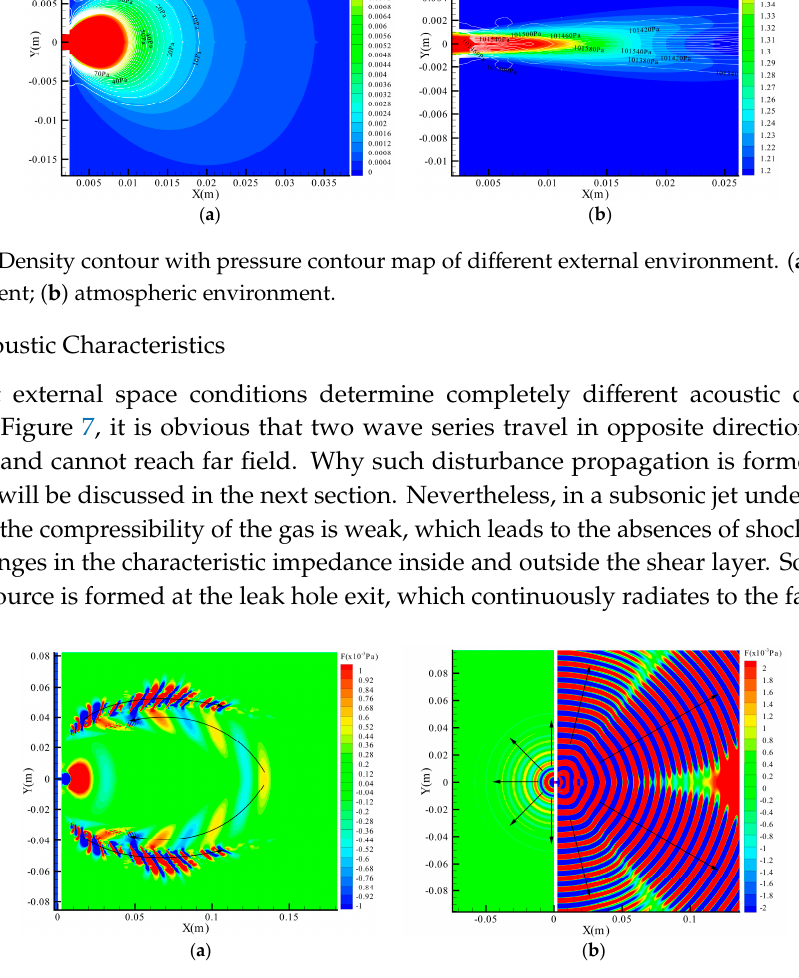
( b ) Figure 8. Velocity contour of different leak hole diameter. ( a ) 1 mm; ( b ) 0.5 mm. Figure 9 shows the density and pressure distribution. In addition to the similar droplet-like shape and large gradient, as the leak hole diameter decreases, the density decreases proportionally to the leak hole diameter in radial direction but shows a flattening trend in the axial direction. The pressure distribution is also similar to the 2 mm leak hole model simulated above and the proportional relation in radial direction and flattening trend in axil direction discovered in the density contour are also observed in the pressure contour map.